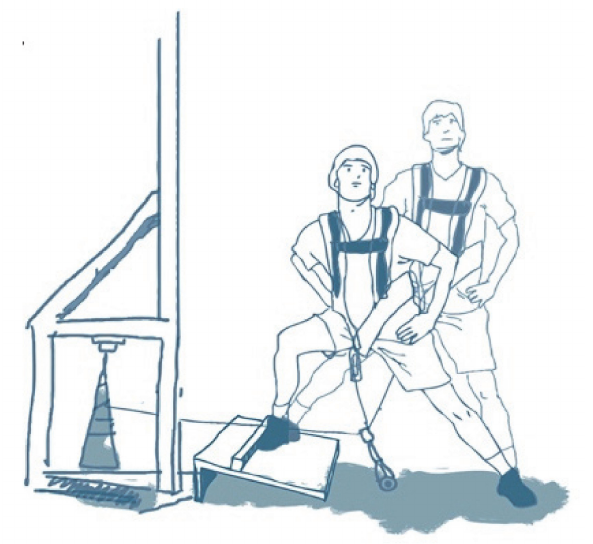
Figure 1. Eccentric overload variable unilateral exercise and the corresponding force-vector applica- tion: lateral squat